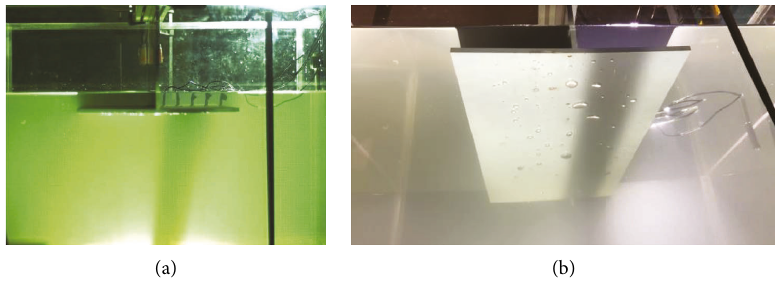
Figure 9: Flow pattern of the flow resistance